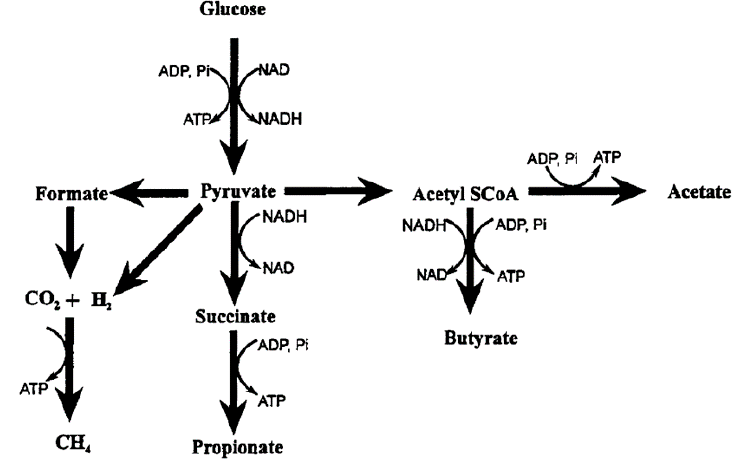
Figure 1. Principal end-products of carbohydrate fermentation in the rumen [18].